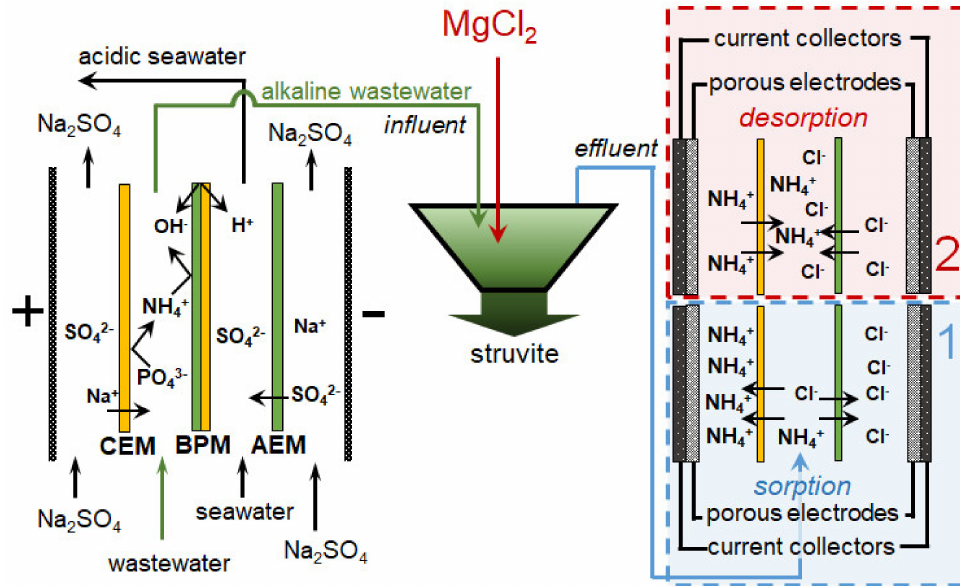
Figure 12. Simultaneous removal and recovery of phosphates and ammonium from wastewater using integrated BMED and MCDI processes. Based on [154].